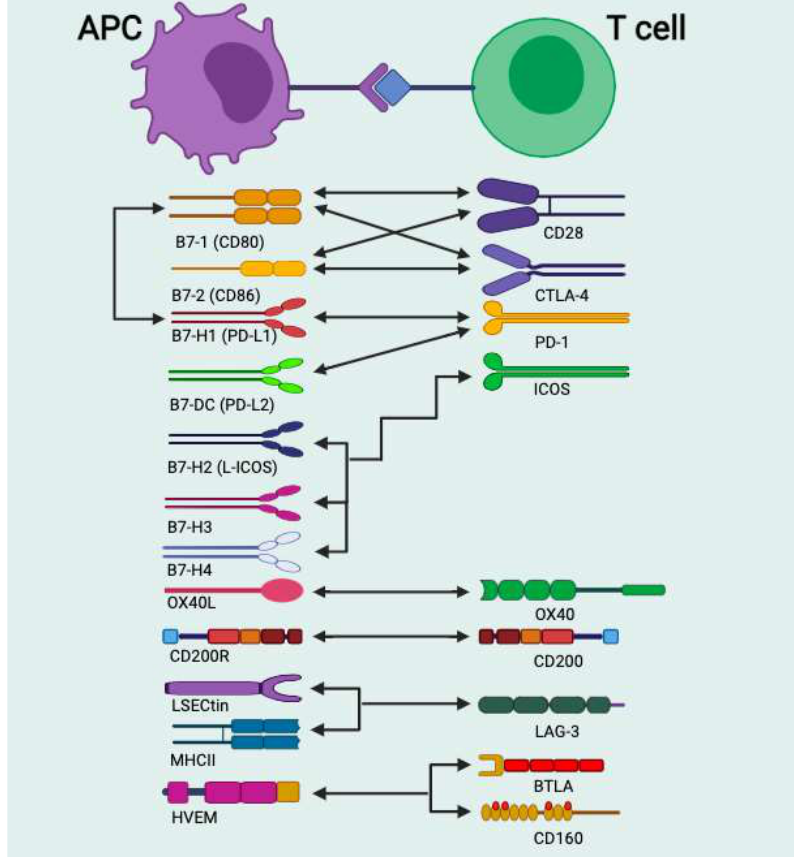
Figure 1. Stimulatory and inhibitory receptors in APCs and antigen-specific T cells. The receptor molecules and their corresponding ligands are shown. CD28:CD80/CD86 and CTLA-4:CD80/CD86 are co-stimulatory molecules. PD-1:PD-L1/PD-L1 CTLA-4, BTLA/HUVEM, and ICOS/ligands are coinhibitory molecules. Arrows show the interaction between receptors and ligands. The triggering stage occurs in two phases, an early and a late phase. The early phase develops after a new exposure to the antigen and binds to antibodies attached to mast cells (MCs), basophils, or eosinophils. This phase causes the activation and releases rapidly of various preformed mediators and others synthesized de novo [19]. The mediators released by MCs and basophils lead to increased vascular permeability, vasodilatation, bronchial, and visceral smooth muscle contraction with local inflammation. The late phase develops without a new antigen presentation and occurs 72 h after the initial exposure. It involves the recruitment of cells, mainly eosinophils and Th2 lymphocytes, which increase mediators that maintain and exacerbate the inflammatory process